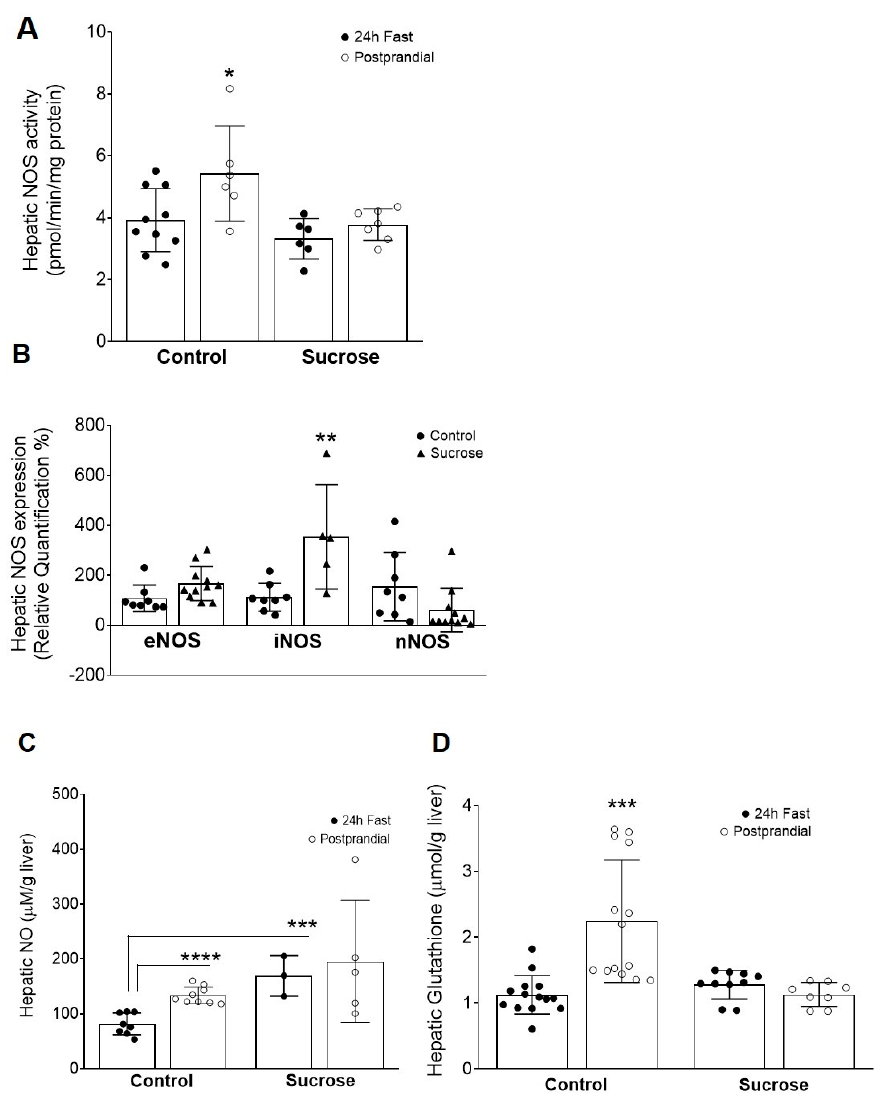
Figure 2. Prolonged exposure to sucrose in the diet leads to changes in hepatic NOS expression and liver levels of NO and GSH. ( A ) Hepatic NOS enzymatic activity in control and sucrose groups; ( B ) gene expression of liver endothelial nitric oxide synthase (eNOS), inducible NOS (iNOS), and neuronal NOS (nNOS) in control and sucrose groups; ( C ) liver levels of nitric oxide (NO) in control and sucrose groups; and ( D ) hepatic glutathione (GSH) in control and sucrose groups. Data are presented as mean ± SEM for 3–11 rats per group. * p < 0.05; ** p < 0.01; *** p < 0.001, and **** p < 0.0001 vs. control group by an unpaired Student’s t test .